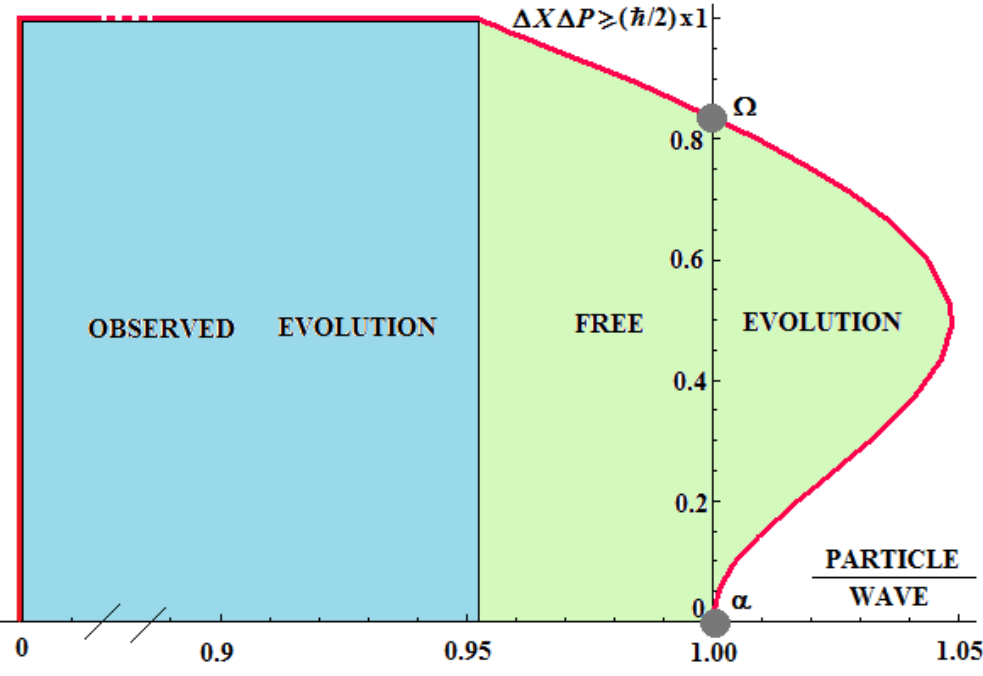
Figure 1. The chart of Heisenberg Uncertainty Relationship (HUR) appearance for observed and free quantum evolutions covering the complete scale of the particle to wave ratios as computed from the Equations (16) and (20), respectively; the points  and  correspond to wave-particle precise equivalence and to the special extended-HURs of Equations (21) and (22),